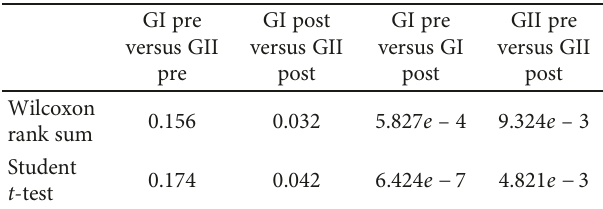
Figure 3: Evolution of the satisfaction scores for groups I (FS and MS) and II (FF and MF). Table 4: Signi fi cance of VHI test results ( p